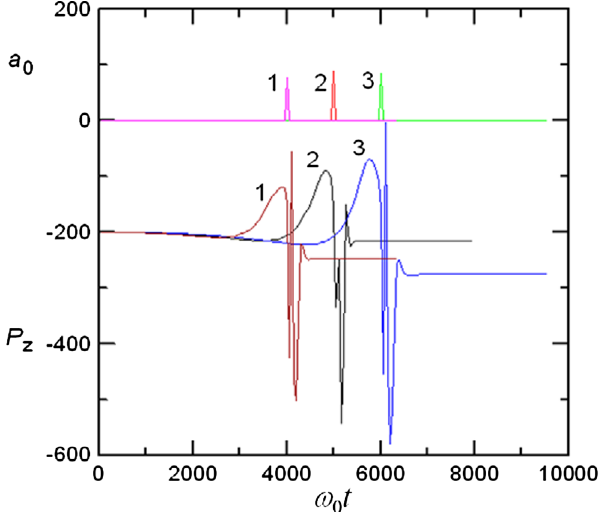
FIG. 7. Evolution of the electron longitudinal momentum in the two pulse scheme: both pulses have a 0 ¼ 100 , τ ¼ 10 fs, and are focused to w 0 ¼ 5 μ m, head-on collision; (1), (2), (3) are given for different delays between the pulses: 0, 45, and 90 fs.